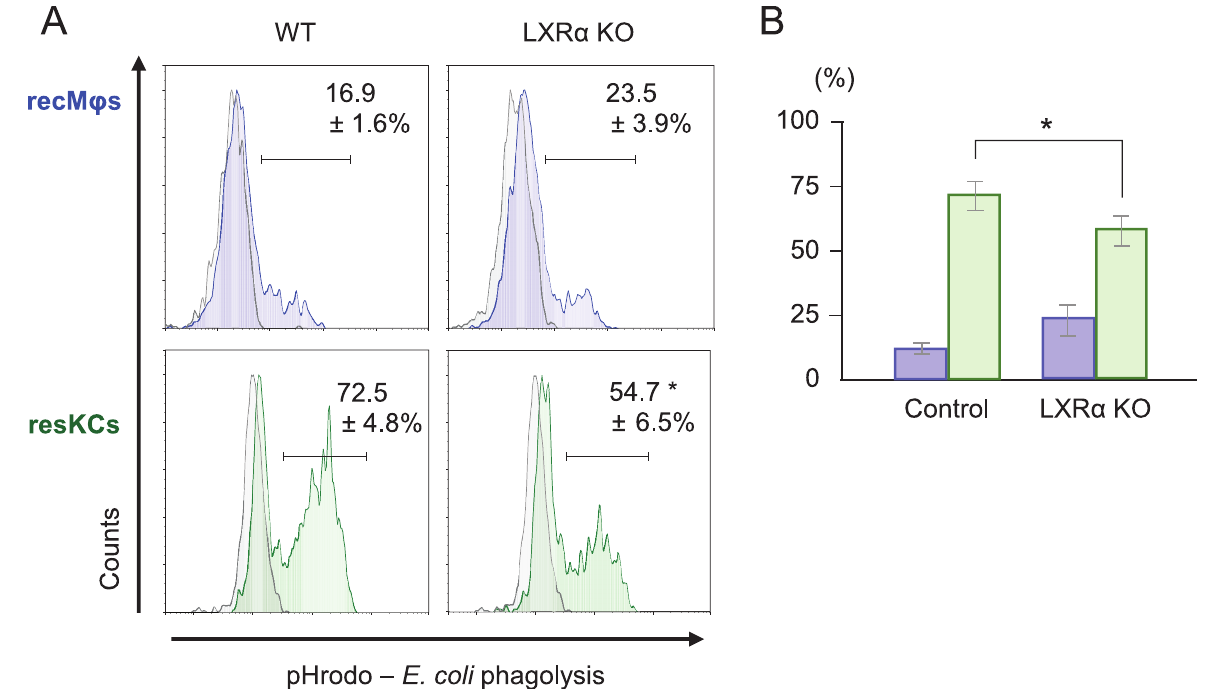
Fig 5. The decreased in vitro phagolytic activity of resKCs from LXR α KO mice against pHrodo E . coli . (A) The phagolytic activity of recM φ s (upper panels, blue line) and resKCs (lower panels, green line). WT and LXR α KO mouse recM φ s and resKCs incubated with pHrodo E . coli on ice were used as negative controls (gray line). (B) Bar graph of the phagolytic activity of recM φ s (blue columns, n = 4) and resKCs (green columns, n = 4). Data are presented as the mean ± SE. ( � p < 0.05, unpaired Student’s t -test).